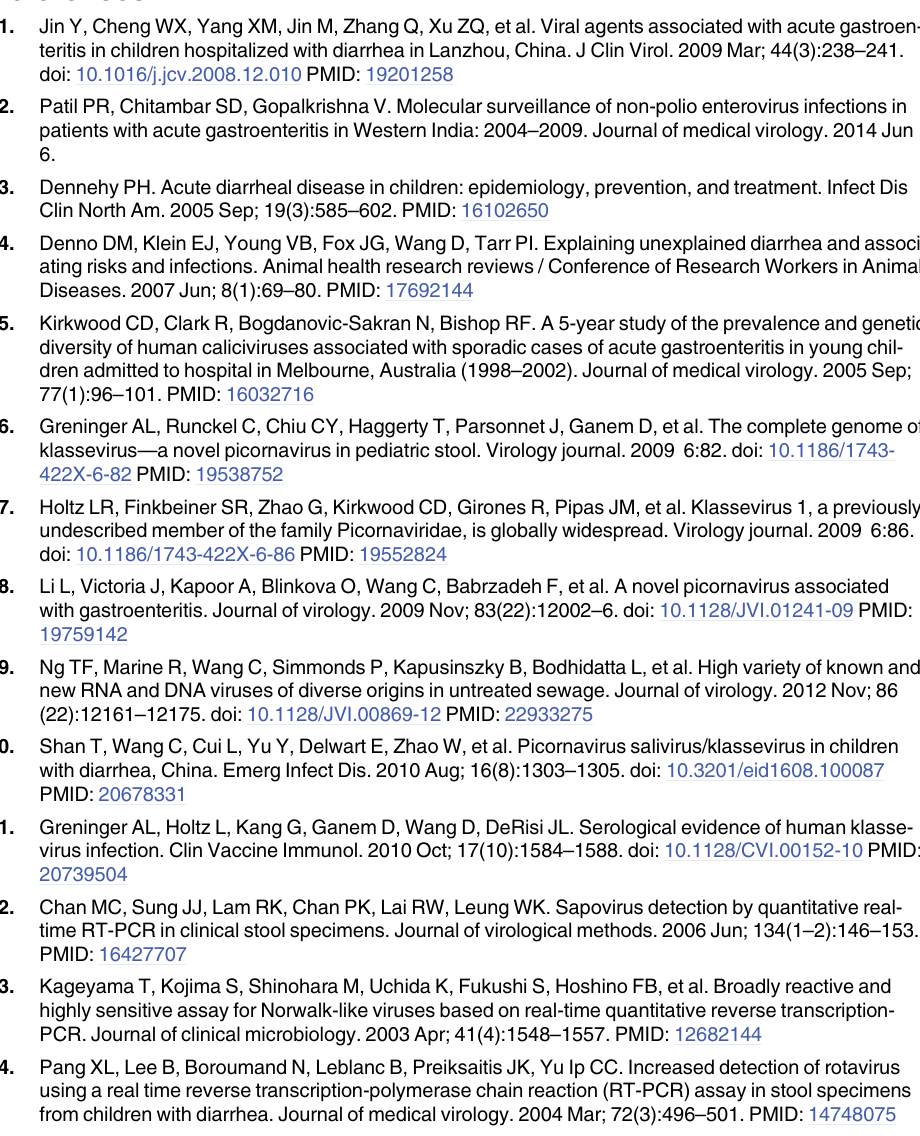
S1 Table. Primers used for complete genome amplification in the study. “ F ” stands for for- ward primer, “ R ” stands for reverse